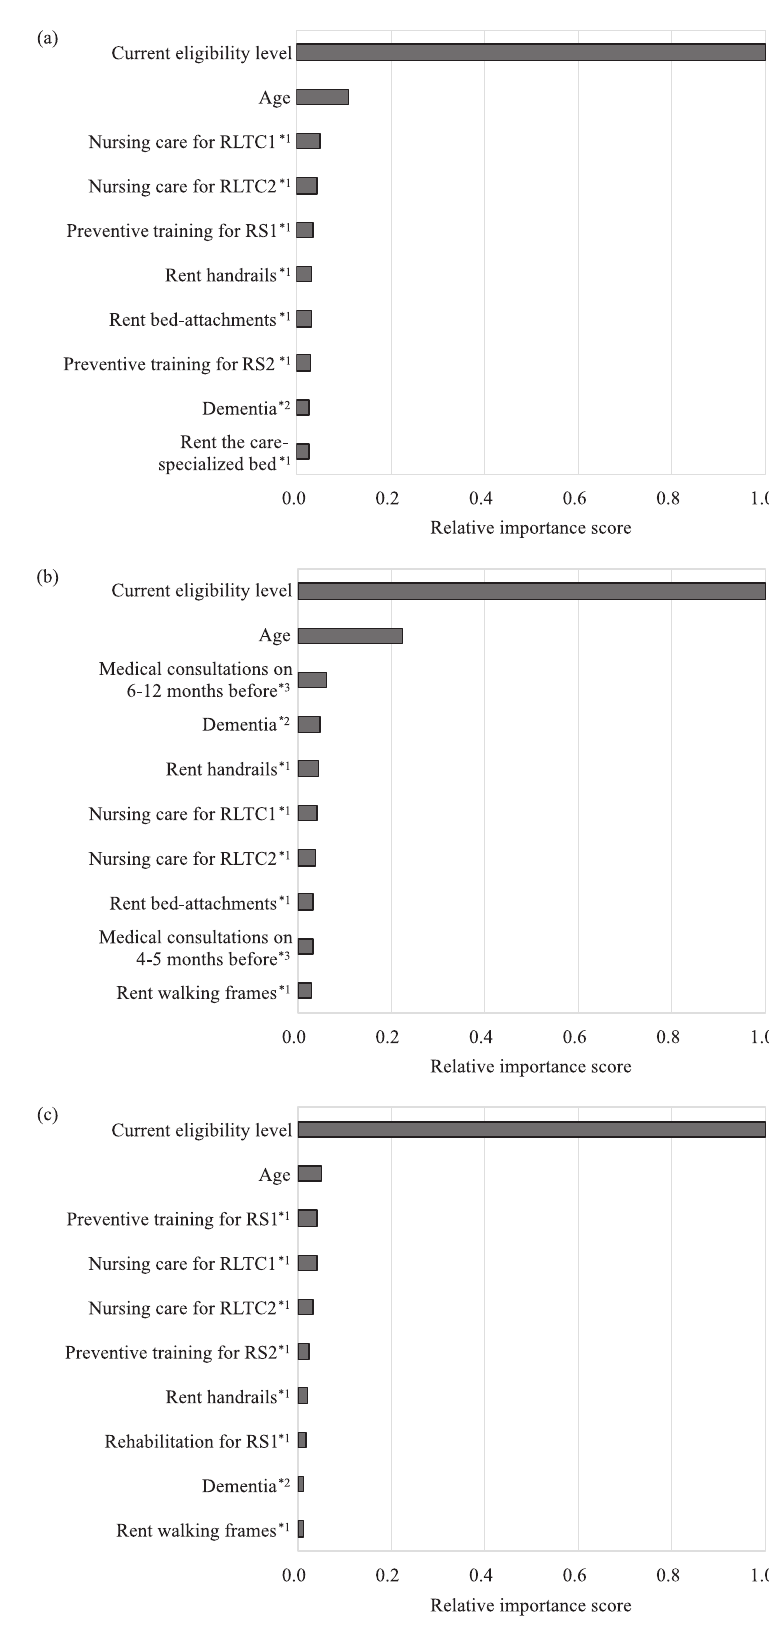
Fig. 3 Top 10 feature variables of prediction models designed by multiclass classi fi cation and GBDT. (a) 3-month prediction; (b) 6-month prediction; and (c) 12-month prediction. 1 * , frequency of occurrence of long-term care service code; 2 * , frequency of occurrence of disease diagnosis code; and 3 * , frequency of occurrence of medical treatment procedure